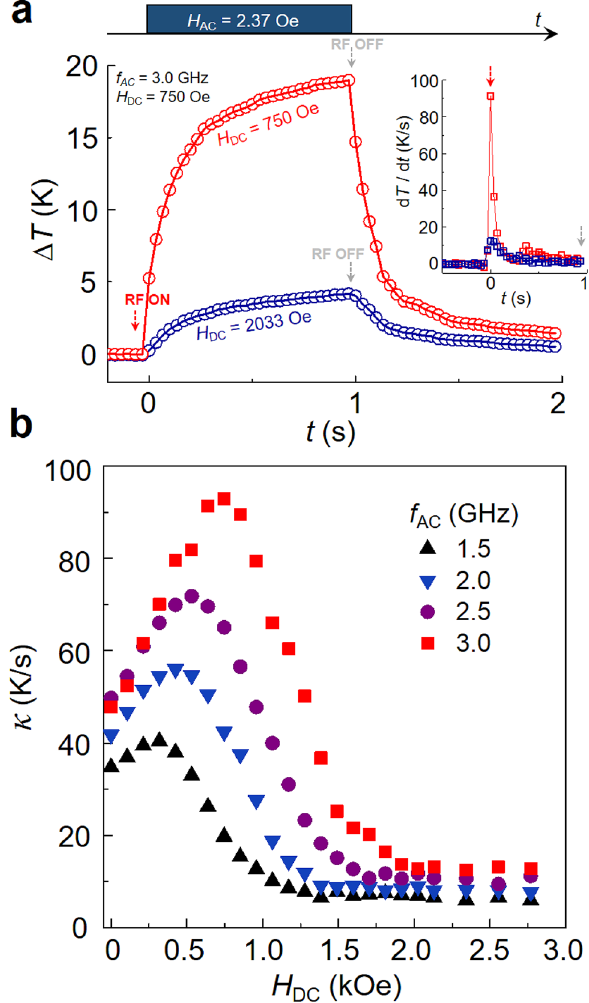
both in-resonance (red symbol, H DC = 750) and off-resonance (blue symbol, H DC = 2033 Oe). The inset shows the time derivatives of the temperature variation, d T /d t . ( b ) Initial temperature increment rate ( κ is defined as d T / d t | ∆t=0 ) as function of strength of DC magnetic field for different frequencies, f AC = 1.5 (black, up triangles), 2.0 (blue, down triangles), 2.5 (purple circles), and 3.0 GHz (red squares). For all of the measurements, a constant strength of AC field, H AC = 2.37 Oe, was